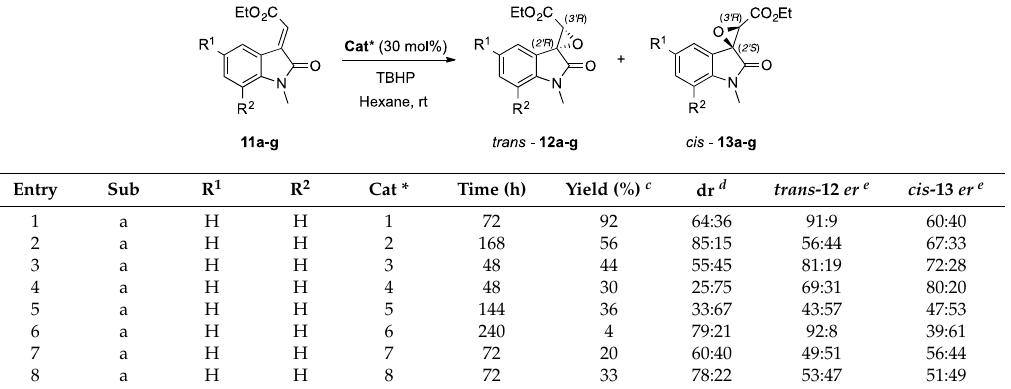
Table 1. Effect of selected organocatalyst ( 1 – 10 , Figure 1) on the asymmetric epoxidation of various N -methyl α -ylidene oxindoles ( 11a – g ) bearing a carboxylate (CO 2 Et) as electron-withdrawing group (EWG) on the exocyclic double bond a,b .